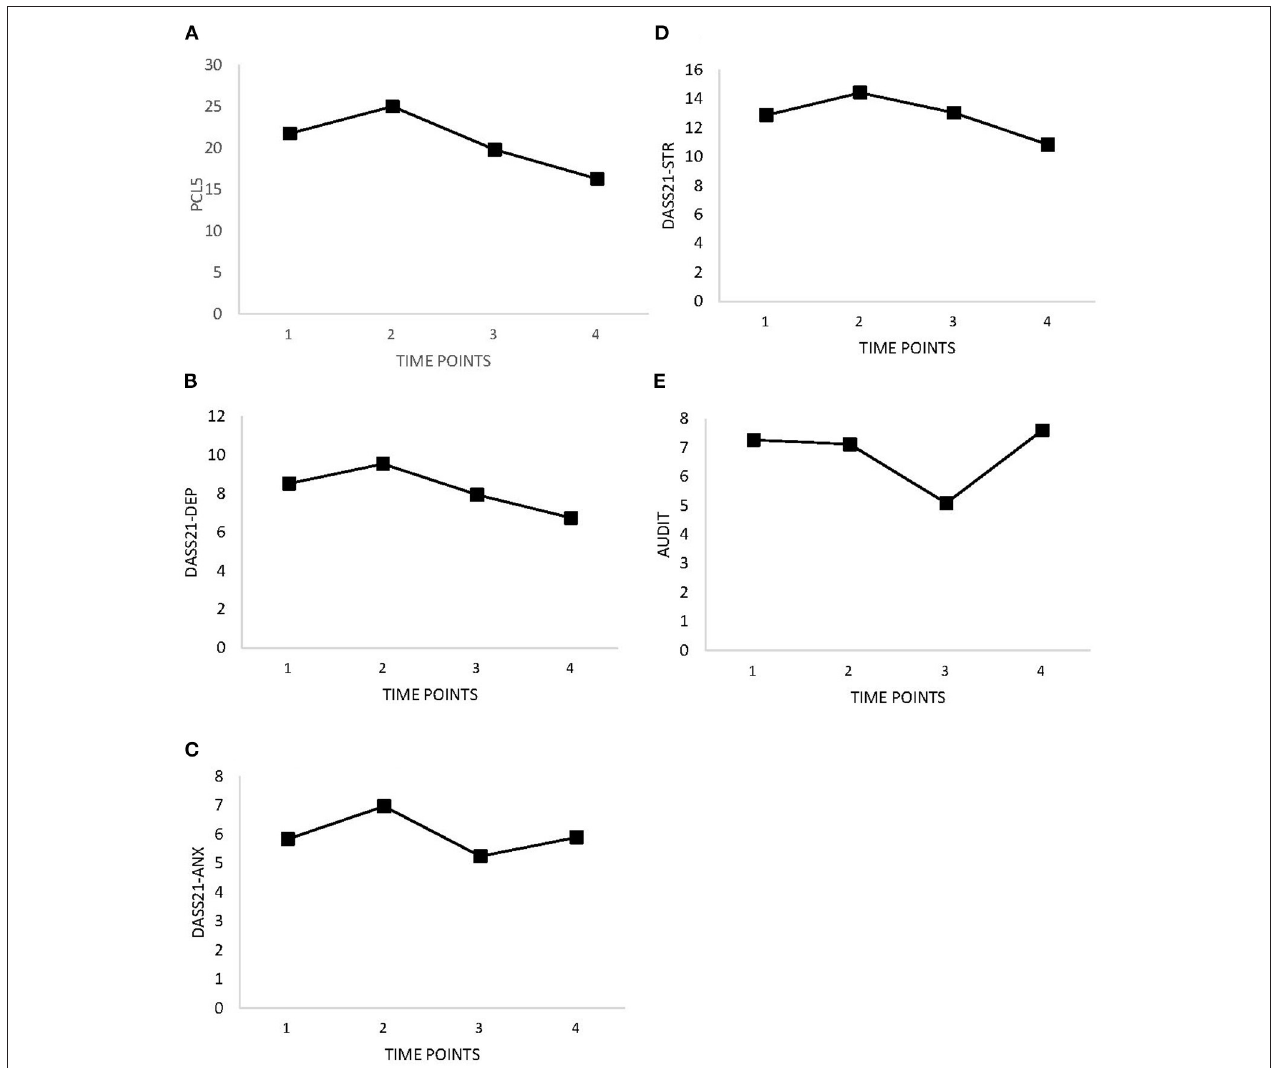
FIGURE 1 | Changes in self-reported mental disorder symptoms as measured at baseline (Time 1), 8 weeks (Time 2), 3 months (Time 3), and 6 months (Time 4). (A) PTSD (PCL-5). (B) Depression (DASS-21). (C) Anxiety (DASS-21). (D) Stress (DASS-21). (E) Alcohol Use Disorder